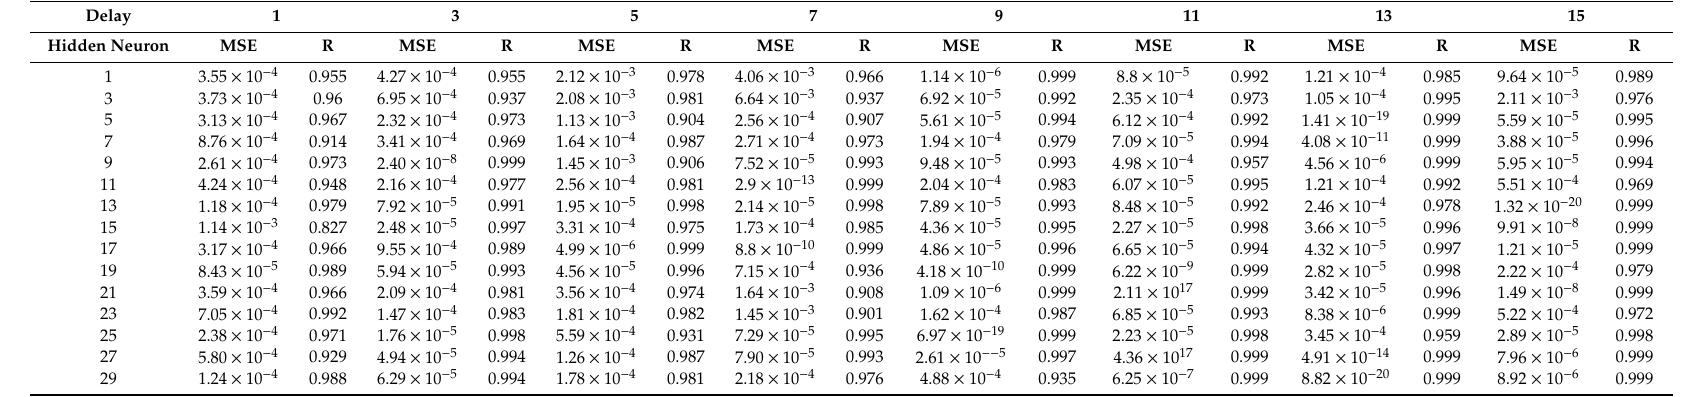
Table A4. Detail results of the optimization of the hidden neurons at varying delay using training data for